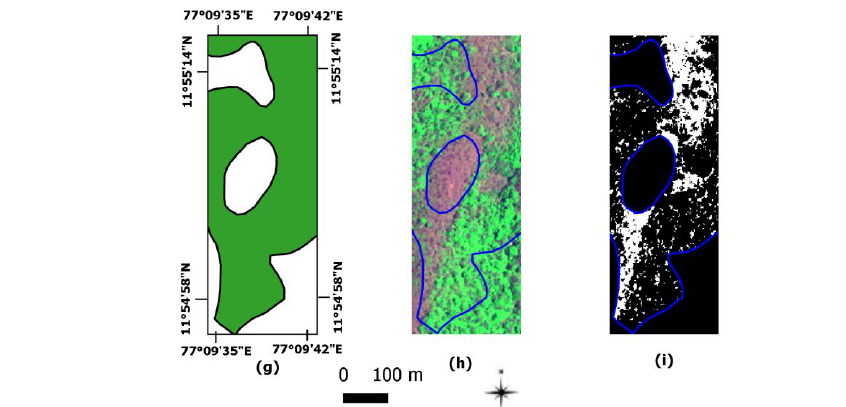
Figure 14 Figure 14. Experiment 2.b—CCA_VHR close-up areas from Figure 13, Indian site: ( a – c ) close-ups in Figure 13c, red circle where the new road appears at T 2 in an evergreen forest area (the blue polygon overlaid on the images); ( d – f ) are close-ups in Figure 13c, blue circle, where forest degradation or community changes may have occurred at T 2 in an evergreen forest; and ( g – i ) close-ups in Figure 13c, yellow circle. In these areas, deforestation appears to have occurred at T 2 , as documented by the VHR image in ( h